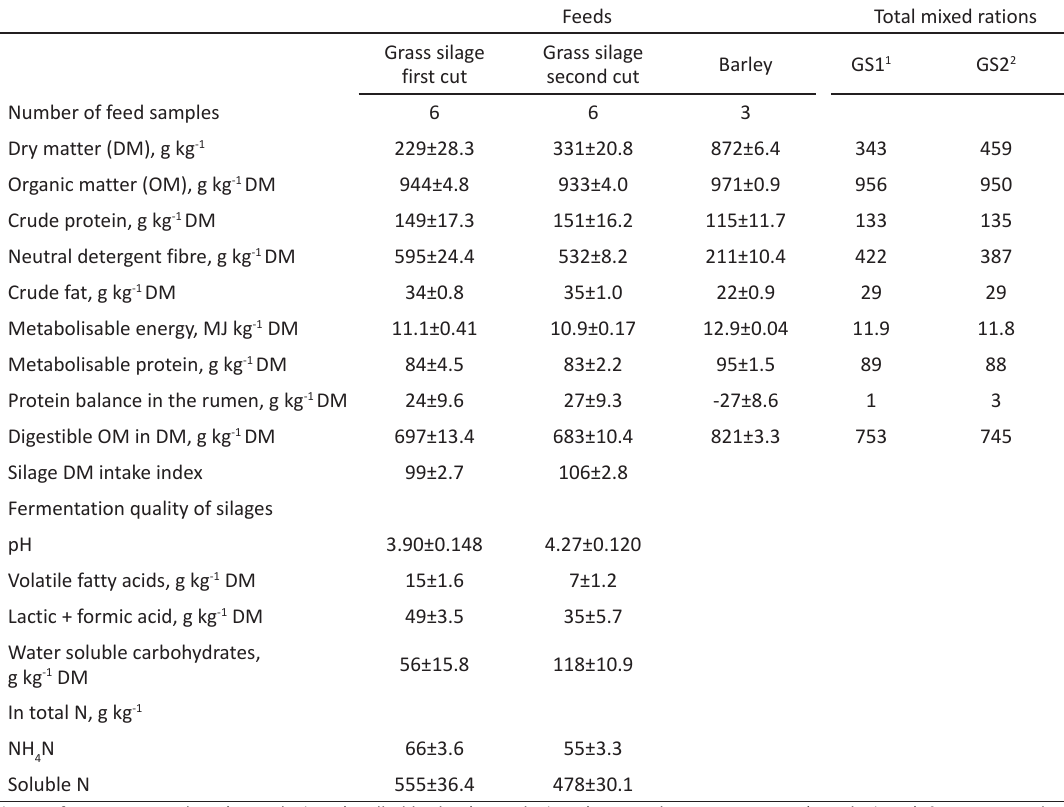
Table 3. Chemical composition and feeding values (mean ± standard deviation) of the ingredients and total mixed rations (calculated) used in the feeding experiment.